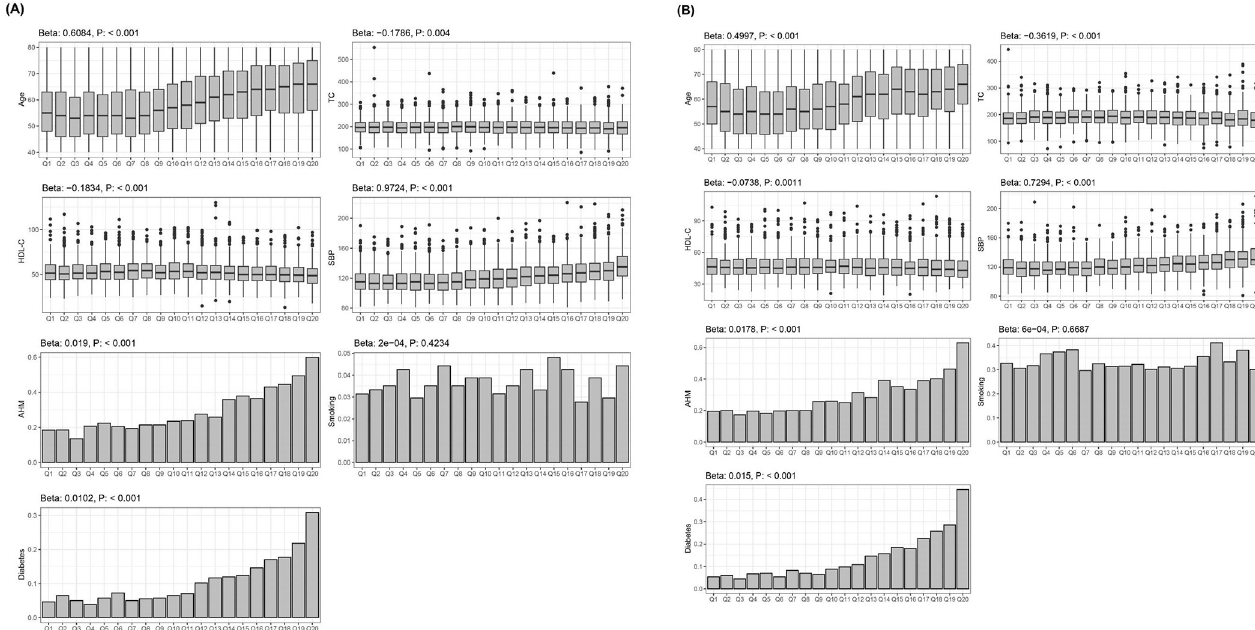
Fig 2. Relationship between UACR and cardiometabolic risk factors in Korean women (A) and men (B). Beta values were measured by linear regression after setting continuous variables, including age, TC, HDL-C, and SBP as dependent variables and UACR subgroups as independent variables. In case of features exhibiting binomial distribution, such as AHM use, smoking, and diabetes, the ratio of presence of disease or status was set as the dependent variable in the linear regression for the calculation of the Beta value. Abbreviations: UACR, urinary albumin-creatinine ratio; Beta, beta-coefficient; AHM, anti-hypertensive medication; HDL-C. high-density lipoprotein-cholesterol; SBP, systolic blood pressure; TC, total cholesterol.